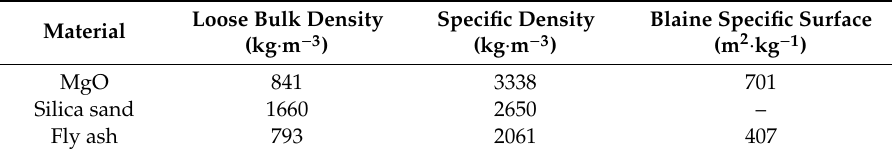
Table 2. Physical parameters of MgO, silica sand, and fly ash.